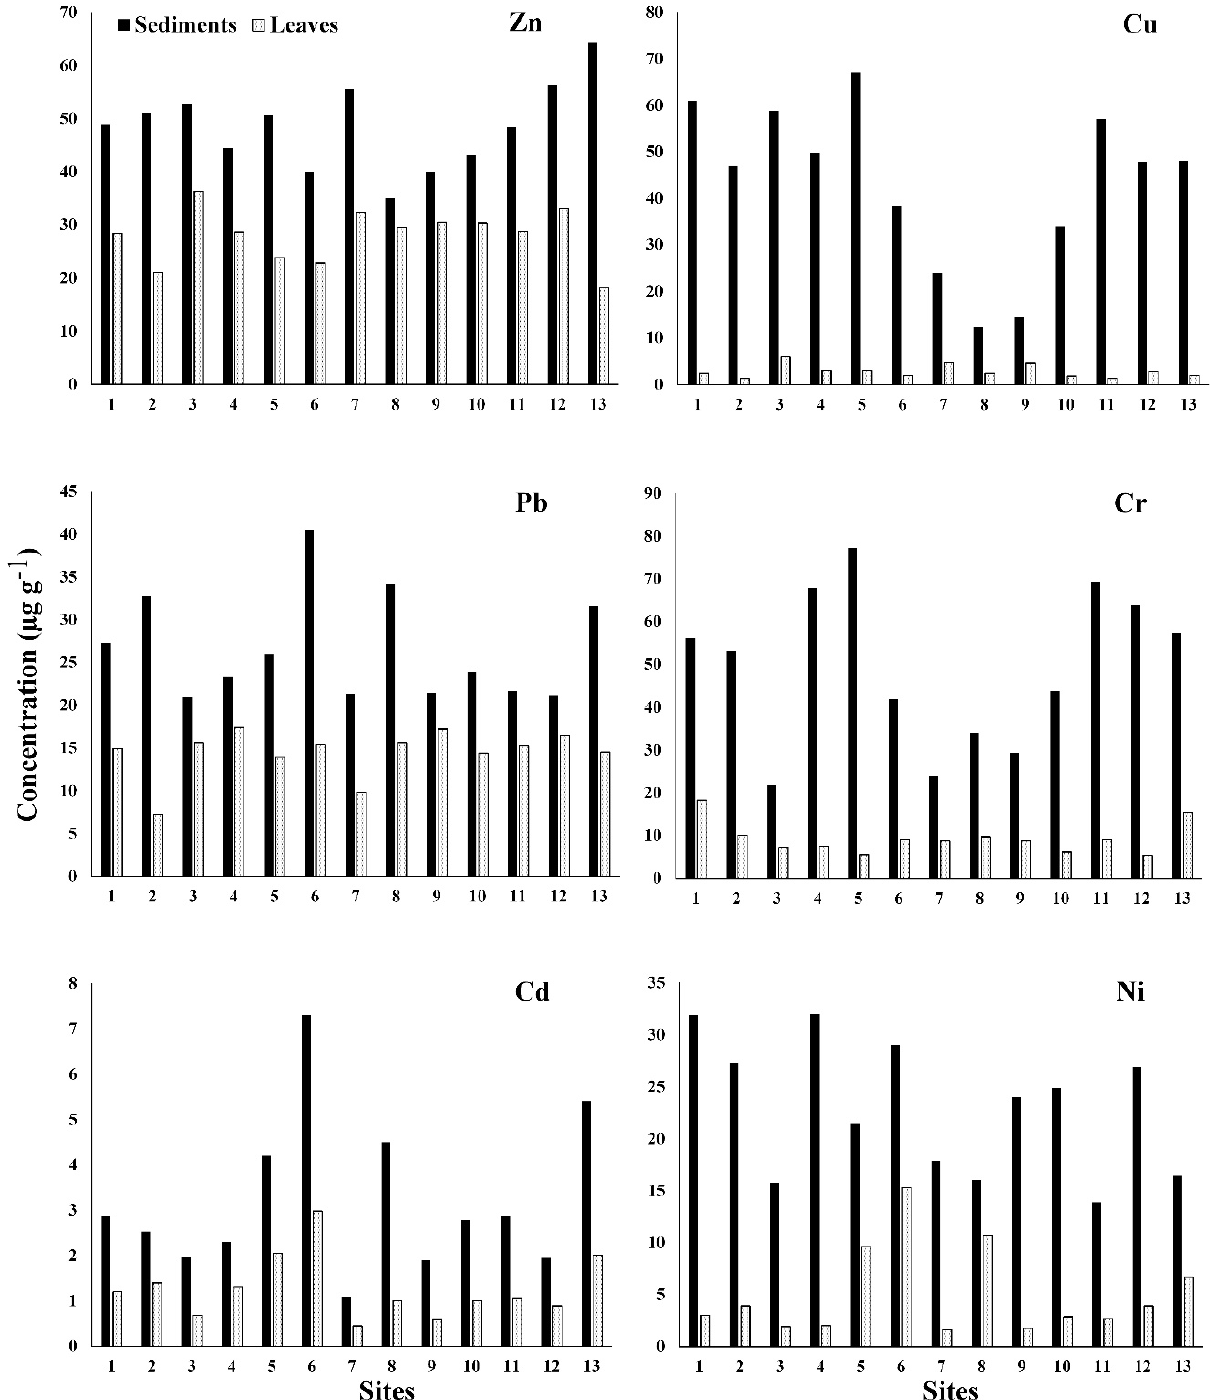
Figure 2: Spatial distribution of different trace elements (μg g -1 ) in sediments and mangrove leaves along the Arabian Gulf coastal